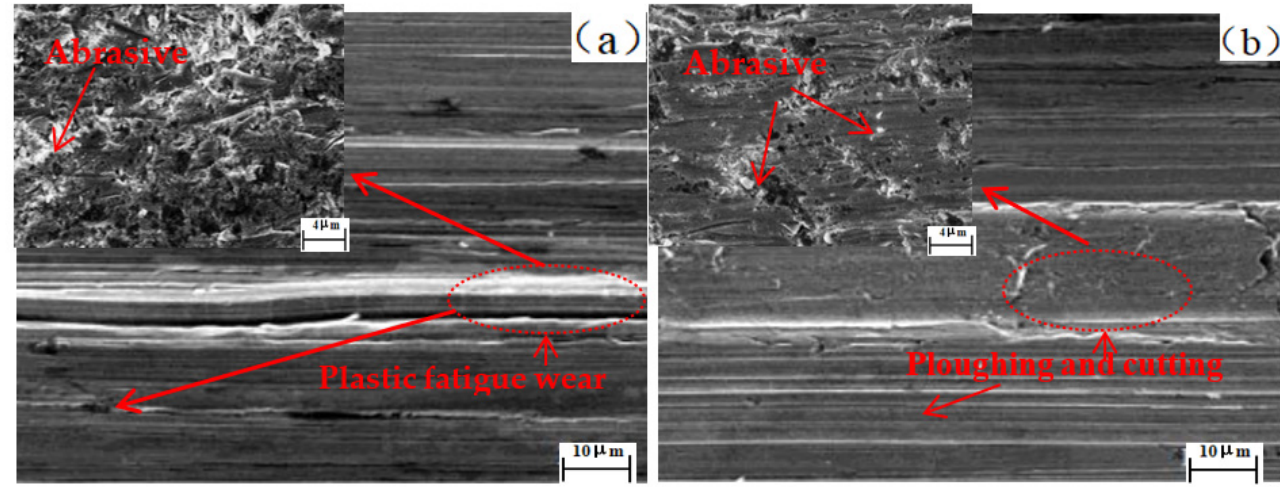
Figure 17. Wear morphology of the tested steels surface (( a )—1#, ( b )—2#).